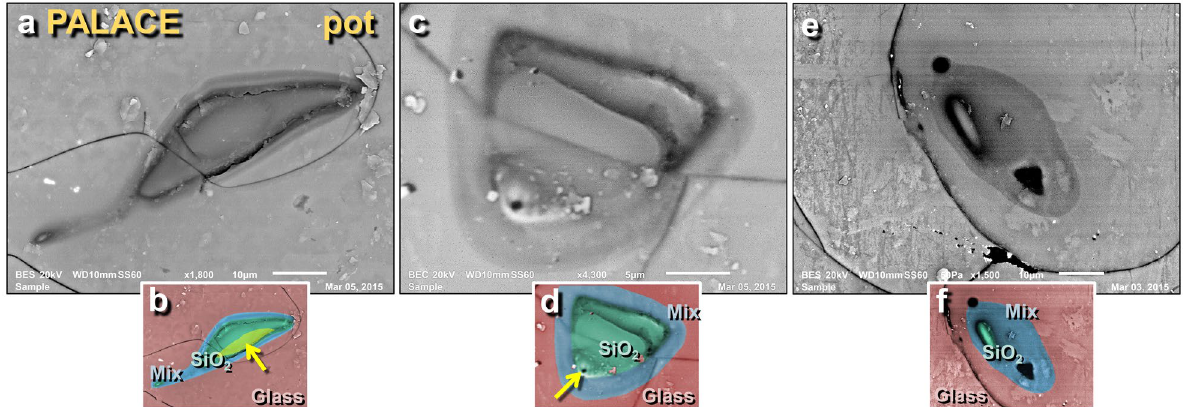
Figure 22. SEM images of melted quartz grains on melted potsherd from the palace. ( a ) Highly melted quartz grain from the upper surface of melted pottery; shows flow lines of molten quartz in darker ‘neck’ at upper right; ( b ) manually constructed EDS-based phase map showing 100% quartz grain (green) embedded in Ca–Al–Si matrix of melted pottery (red); blue marks mixing zone between SiO 2 and matrix at approximately > 1713 °C, the melting point of quartz. Yellow arrow points to area depleted in oxygen, indicating high-temperature transformation to elemental Si mixed with melted SiO 2 . ( c ) Highly melted quartz grain; ( d ) manually constructed EDS-based phase map showing diffusion/mixing zone in blue with arrow pointing to bubble, indicating outgassing as grain reached temperatures above its melting point. ( e ) Quartz grain that has almost completely melted; ( f ) manually constructed EDS-based phase map showing the small remnant of a melted quartz grain (green) with a wide mixing zone